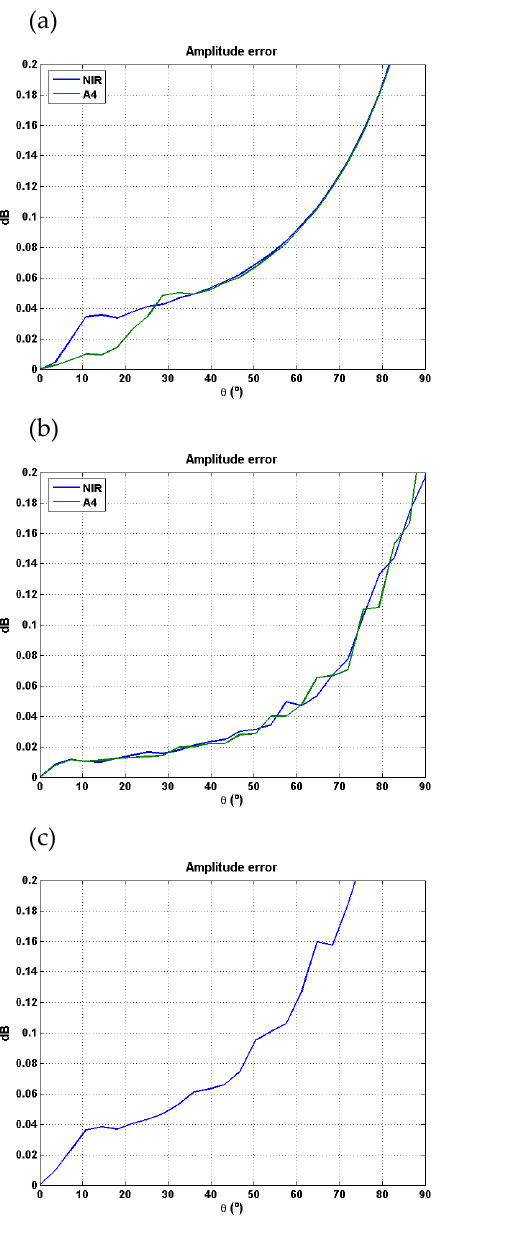
Figure A2. Antenna pattern measurement errors for two antennas (green and blue plots, left: amplitude, right: phase) associated to: ( a ) wall reflections; ( b ) thermal noise; and ( c ) both wall reflections and thermal noise.